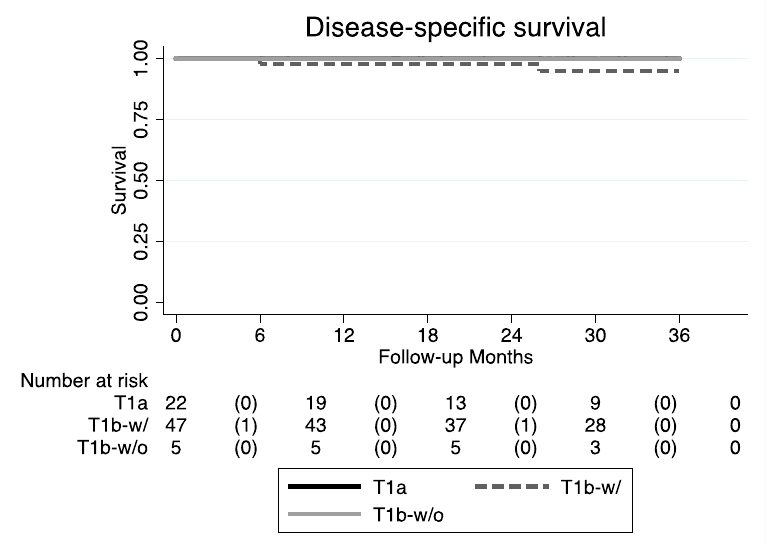
Figure 6. DSS Kaplan–Meier curves (T1b-w / : T1b with AC involvement; T1b-w / o: T1b without AC involvement).